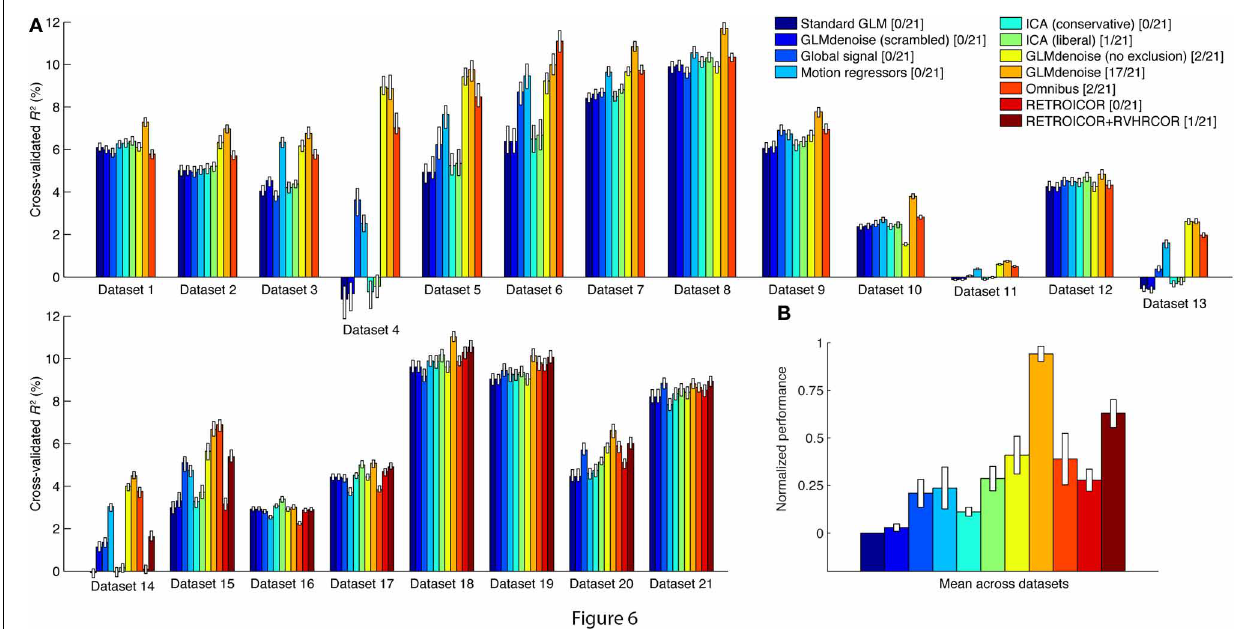
FIGURE 6 | GLMdenoise outperforms other denoising methods. Using the DNB, we quantified the cross-validation accuracy of a variety of denoising methods on a large number of datasets. (A) Results for individual datasets. For each dataset, we summarize the performance of a method by plotting the median cross-validated R 2 value obtained under that method. Error bars indicate 68% confidence intervals and were obtained via bootstrapping. (B) Overall results. To summarize performance across datasets, we normalize the pattern of results from each dataset such that Standard GLM